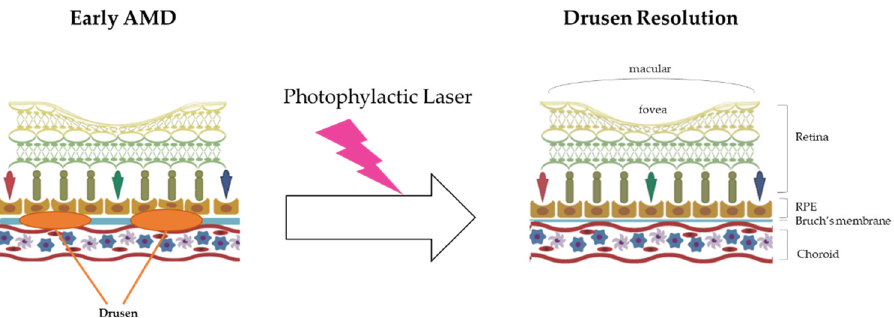
Figure 1. The mechanism of prophylactic laser therapy (photocoagulation therapy). In the early AMD stage, the drusen in Bruch’s membrane inhibit the blood supply to the RPE and eliminate the wastes near that area, such as lipofuscin (A2E). Finally, the accumulation of drusen in this area induces RPE death and worsens AMD. With energy (heat), prophylactic laser therapy resolves the build-up of drusen and then suppresses AMD progress. Table 3. Summary of the prophylactic/photocoagulation laser therapeutics. Advantage and Disadvantage Resolves drusen but induces RPE death. Decreases RPE death but insufficiently. Decreases AMD progress but is not well